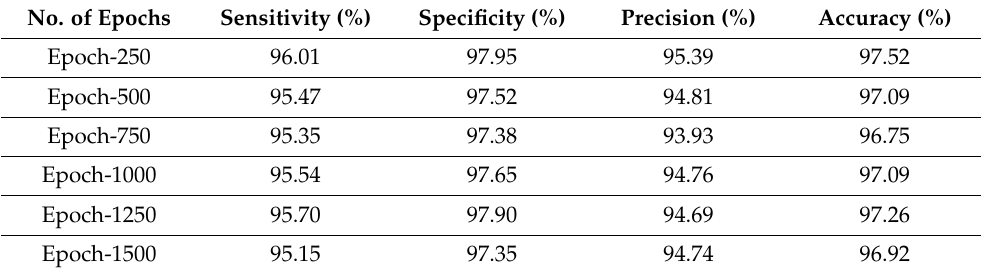
Table 2. Average analysis results for the EDLCDS-BCDC technique under different measures.